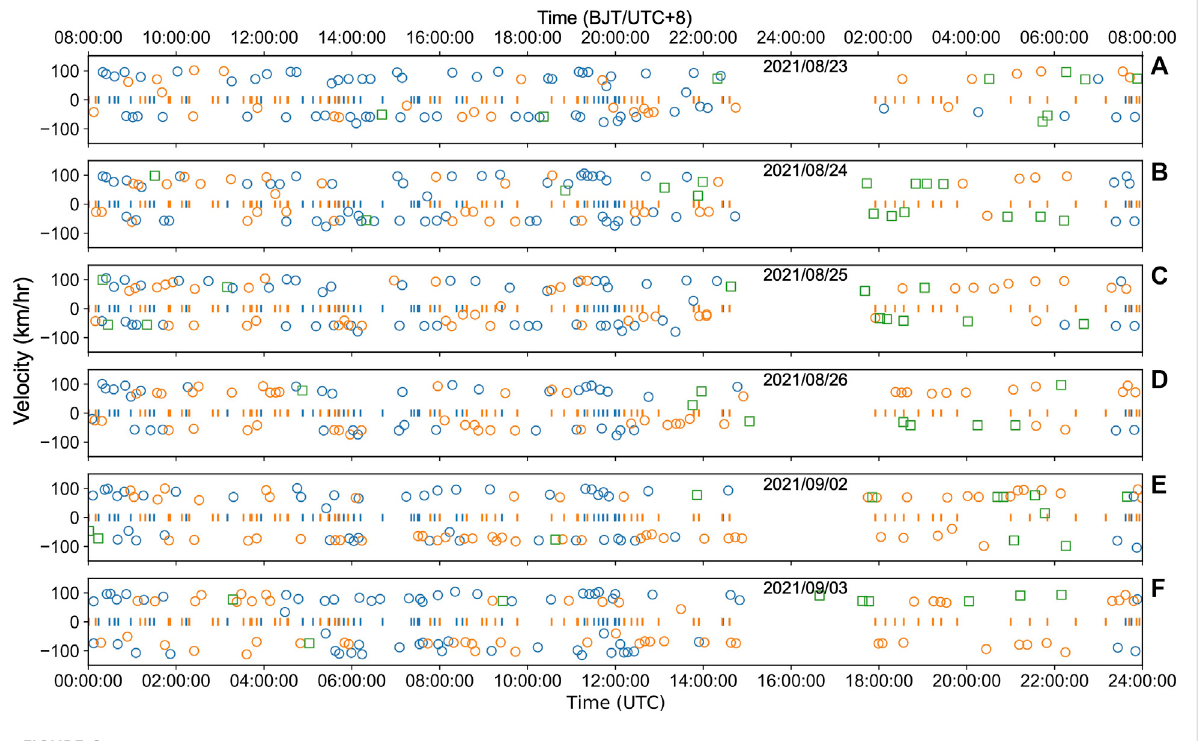
FIGURE 6 Detections, train speeds, and train types extracted from 6-days data. Negative and positive speed values correspond to N-S and S-N, respectively. Orange, blue vertical lines mark the time on the train timetable (the arrival time for N-S cases, and departure time for S-N). Orange and blue circles represent detected conventional trains and EMU trains, respectively; the hollow squares denote non-scheduled